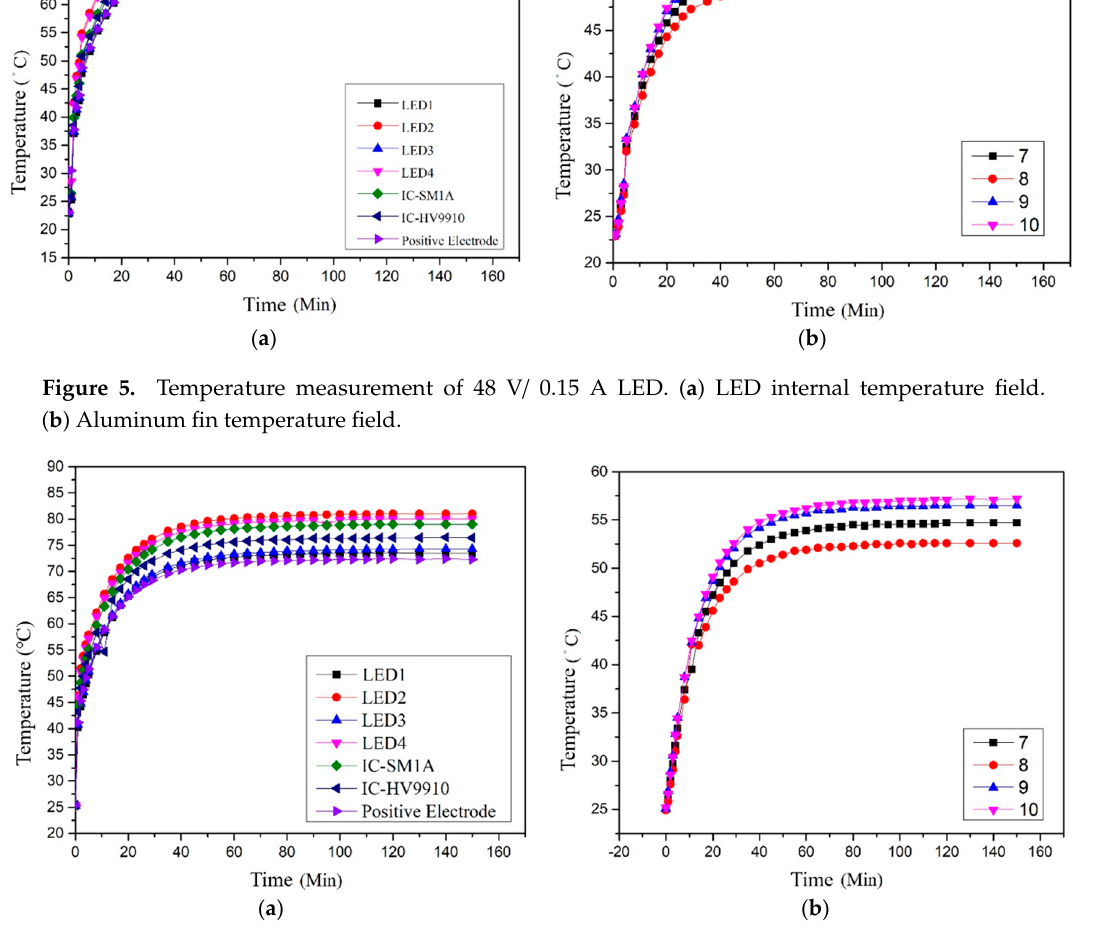
( b ) Figure 7. Mesh of single chip model. ( a ) Mesh. ( b ) Mesh convergence analysis.